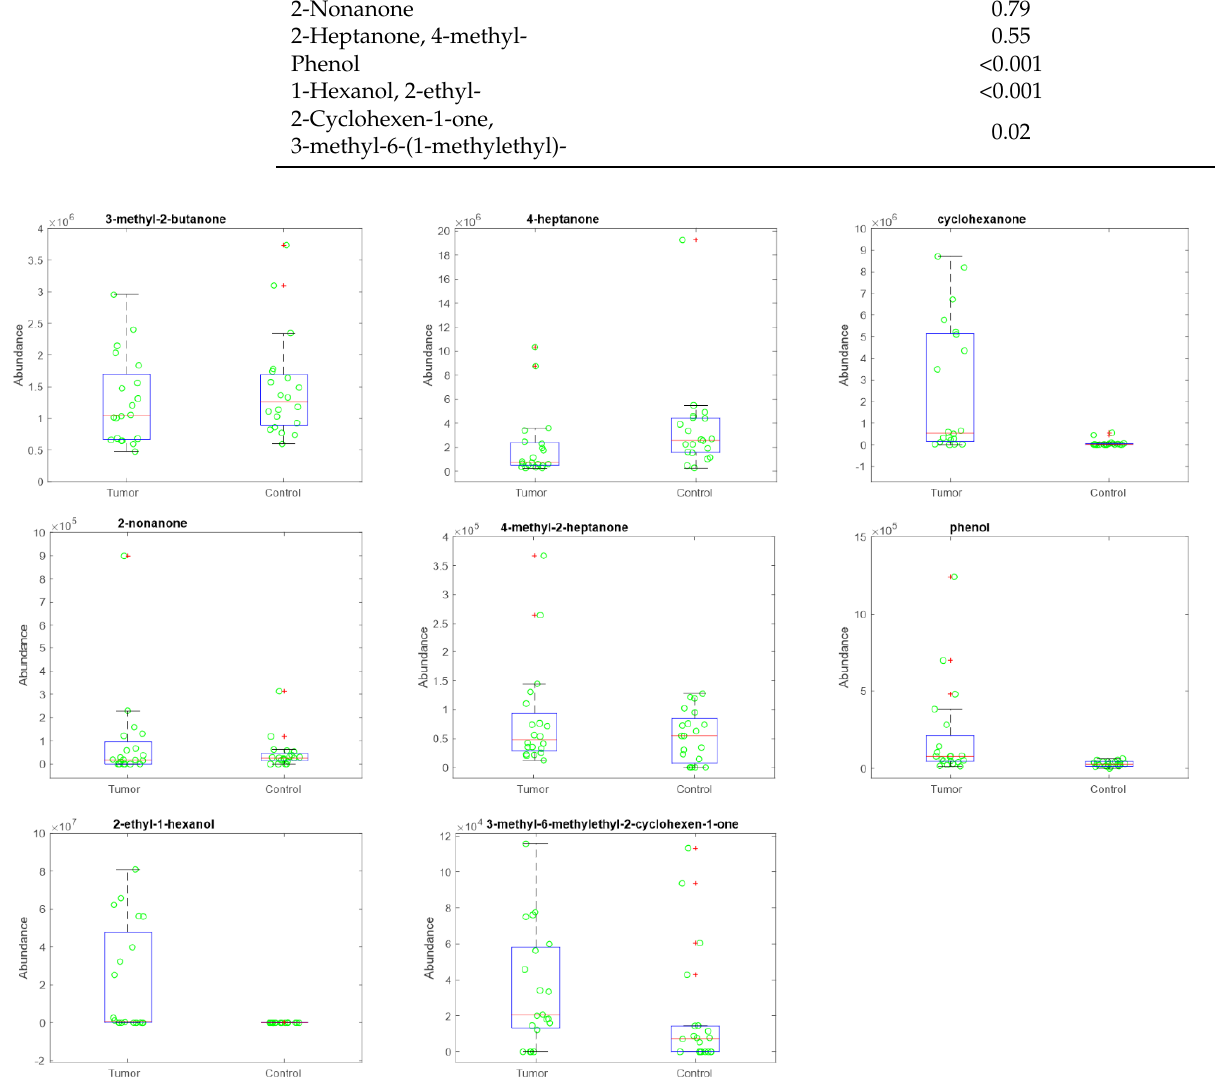
Figure 6. Box plots of the abundances of the most recurrent volatile compounds respect to cancer and control groups.